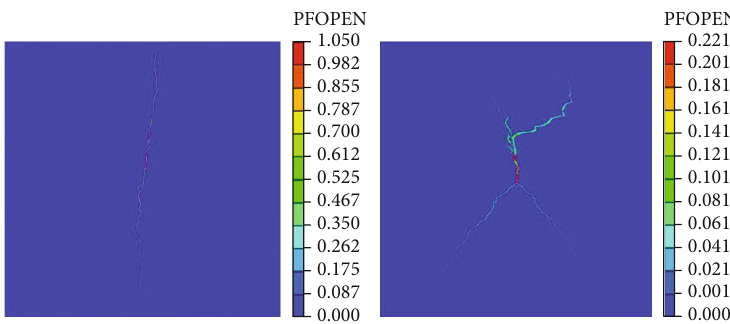
Figure 15: Crack propagation numerical simulation of coals caused by (1) hydraulic fracturing and (2) ScCO